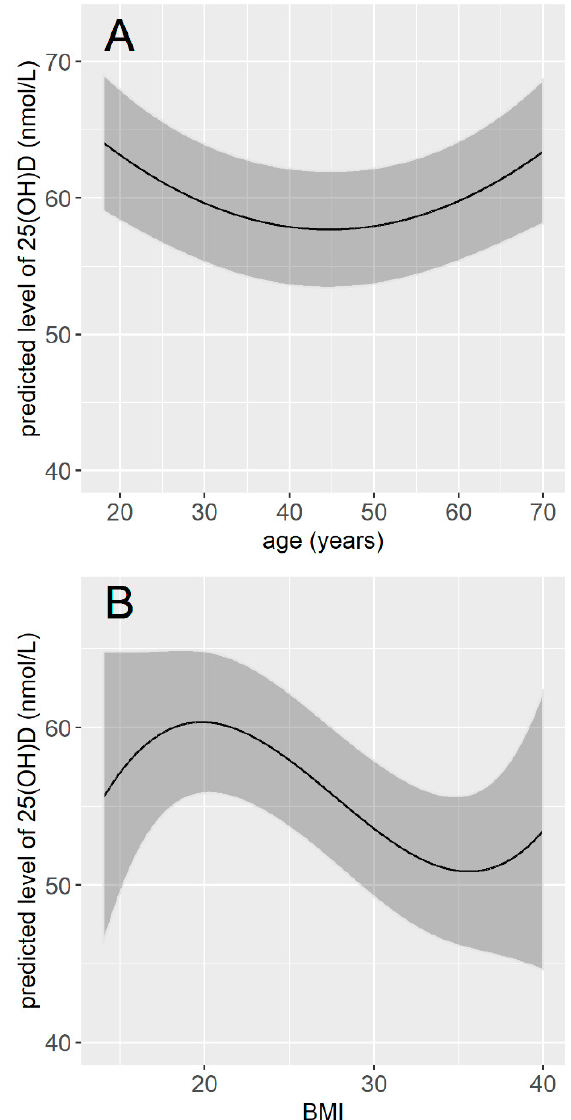
Figure 3. Predicted concentration of vitamin D according to age ( A ) and according to BMI ( B ). The concentrations of vitamin D were predicted for the month of January, for a male, with light-colored skin, employment, living in the North of France, non-smoker, with vitamin D supplementation in the last 12 months, a significant sun exposure over the last 12 months, an average exposure time of 15 h during the week preceding the blood sample, no sporting activity, and for a BMI of 25 ( A ), or an age of 50 years old ( B